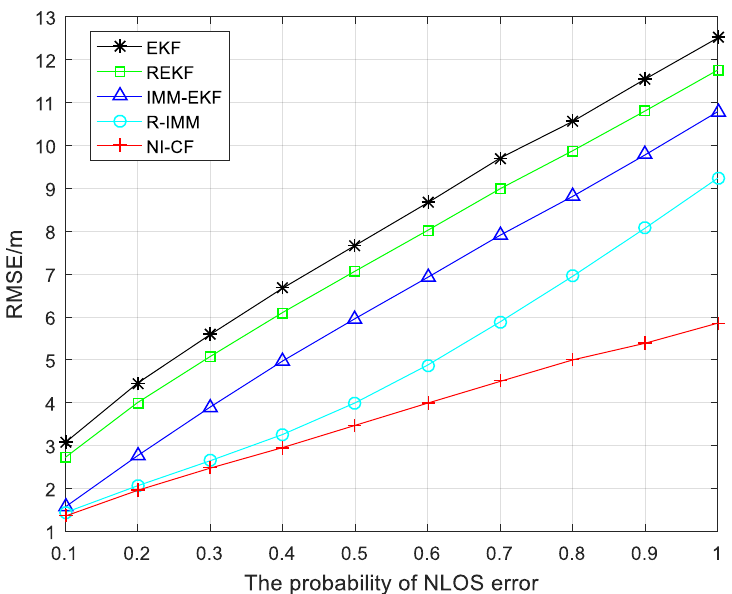
Figure 11. The RMSE versus the probability of NLOS error.